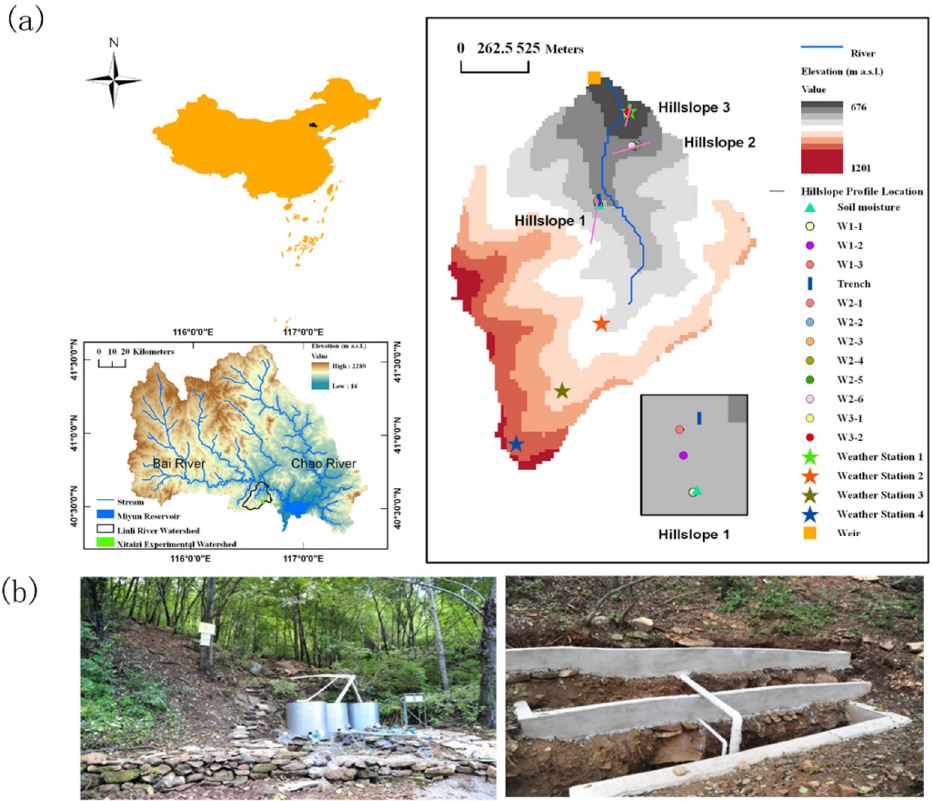
Figure 1. ( a ) Location, elevation, and experiment configuration of the Xitaizi Experimental Watershed (XEW), ( b ) Trench at Hillslope 1 with three PVC tubes collecting subsurface water into 3 tanks.